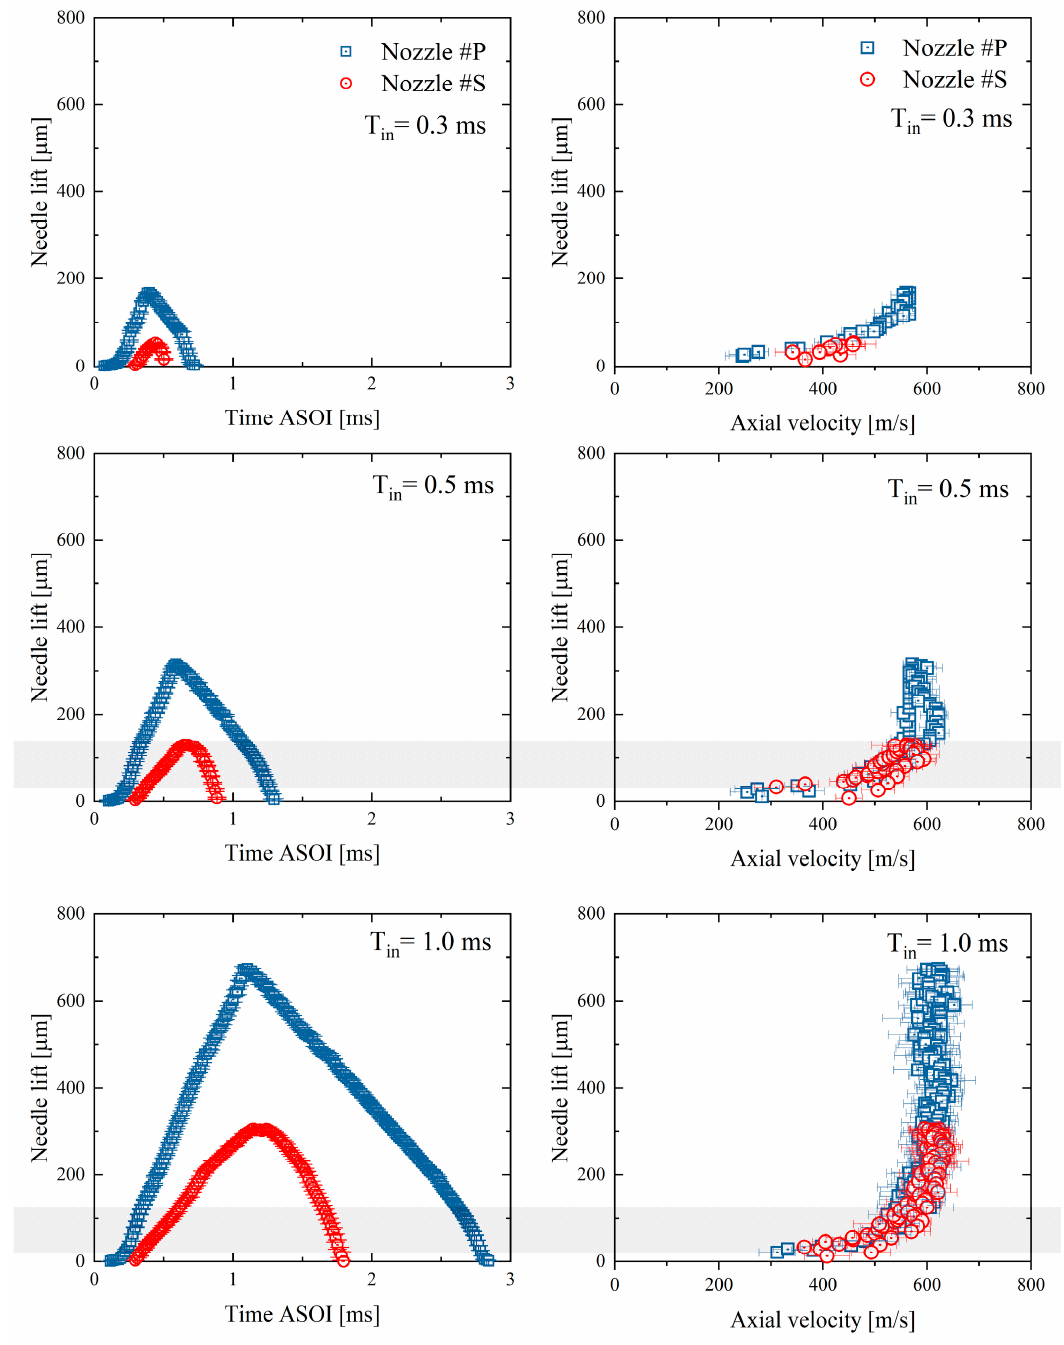
Figure 5. Needle lift sequence results of spray axial velocities at the nozzle exit.